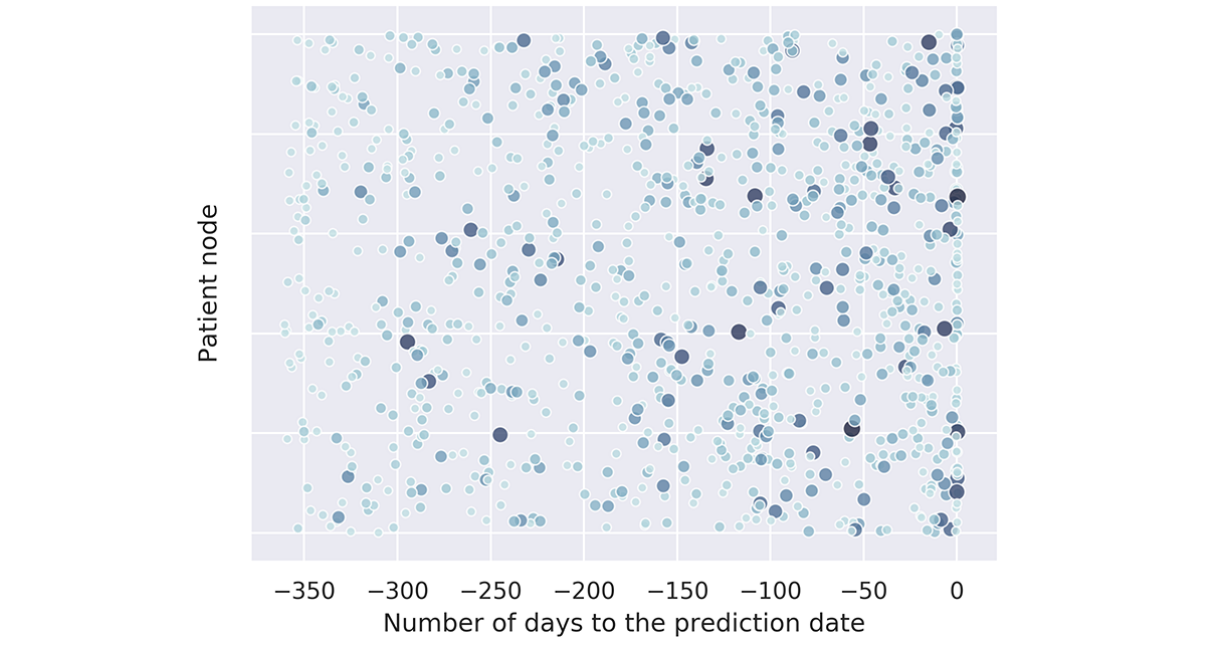
Figure 5. Time distribution of the contribution of the clinical variable gastroesophageal reflux disease is denoted by ICD-9:530.81. ICD: International Classification of Disease Code.